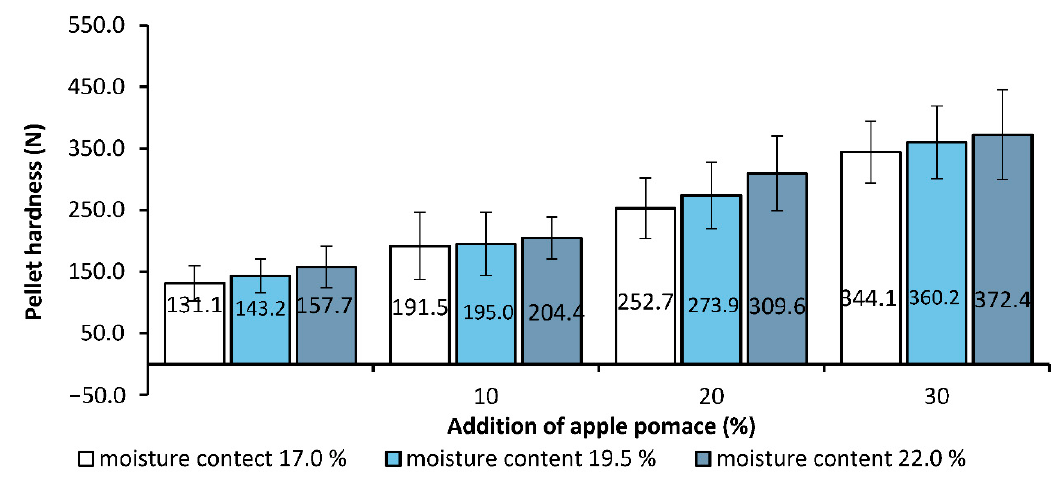
Figure 3. Influence of the contribution of apple pomace in the mix with barley straw and mix moisture content on the hardness of the obtained pellet.